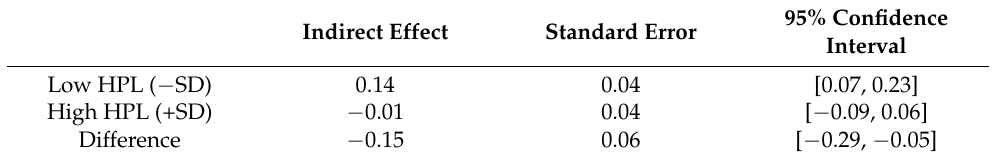
Table 4. Examination of the moderated mediating effect ( n =